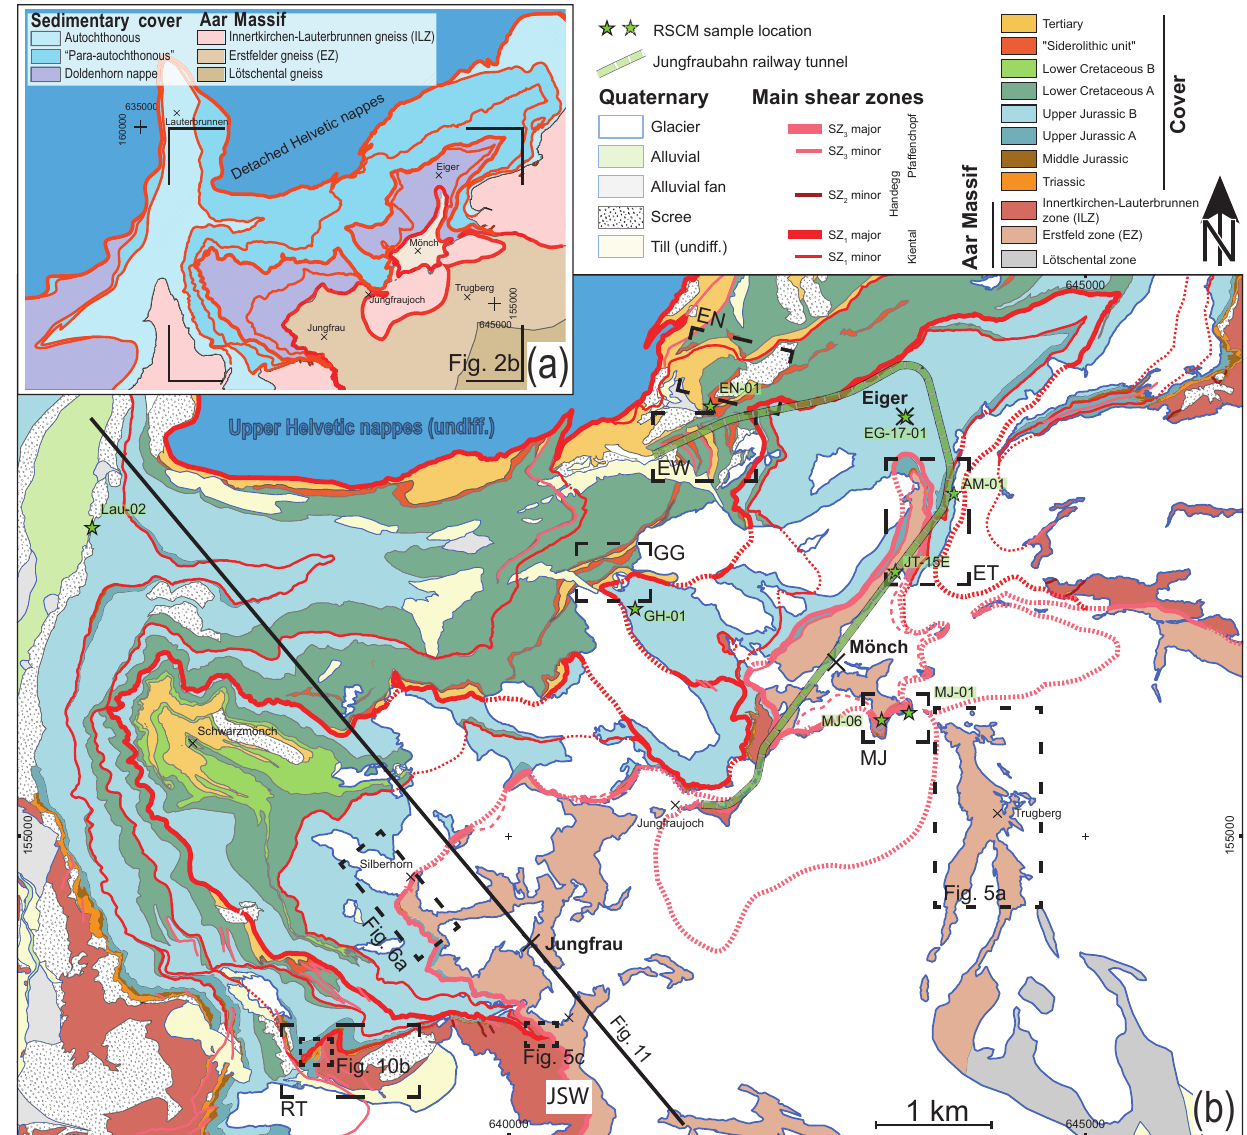
Figure 2. Structural main shear zone map based on own field work and compiled from sources as discussed in Appendix A. (a) Tectonic overview of the studied area. (b) Refined structural and lithological map. Profile trace for Fig. 11 and key locations (EN: Eiger north, GG: Guggi glacier, ET: Eismeer/tunnel, EW: Eiger west, MJ: Mönchsjoch, RT: Rottal, TB: Trugberg; JSW: Jungfrau sediment wedge) are indicated. RSCM sample locations are shown (subsurface samples from the railway tunnel are indicated with dashed stars). Coordinates are given in Swiss coordinates